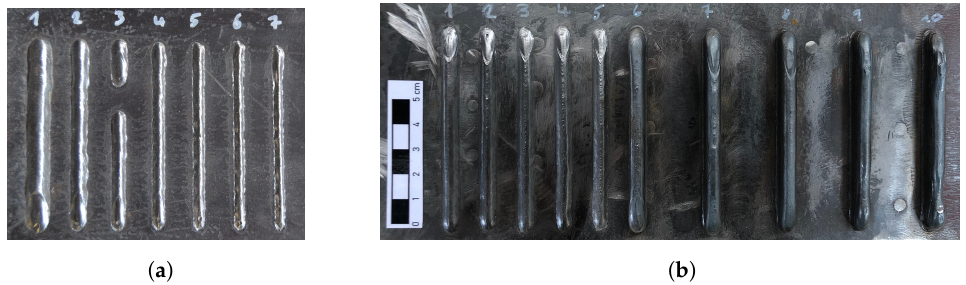
Figure 4. Different travel speeds ( a ) 300 to 2100 mm/min; ( b ) 600 to 1000